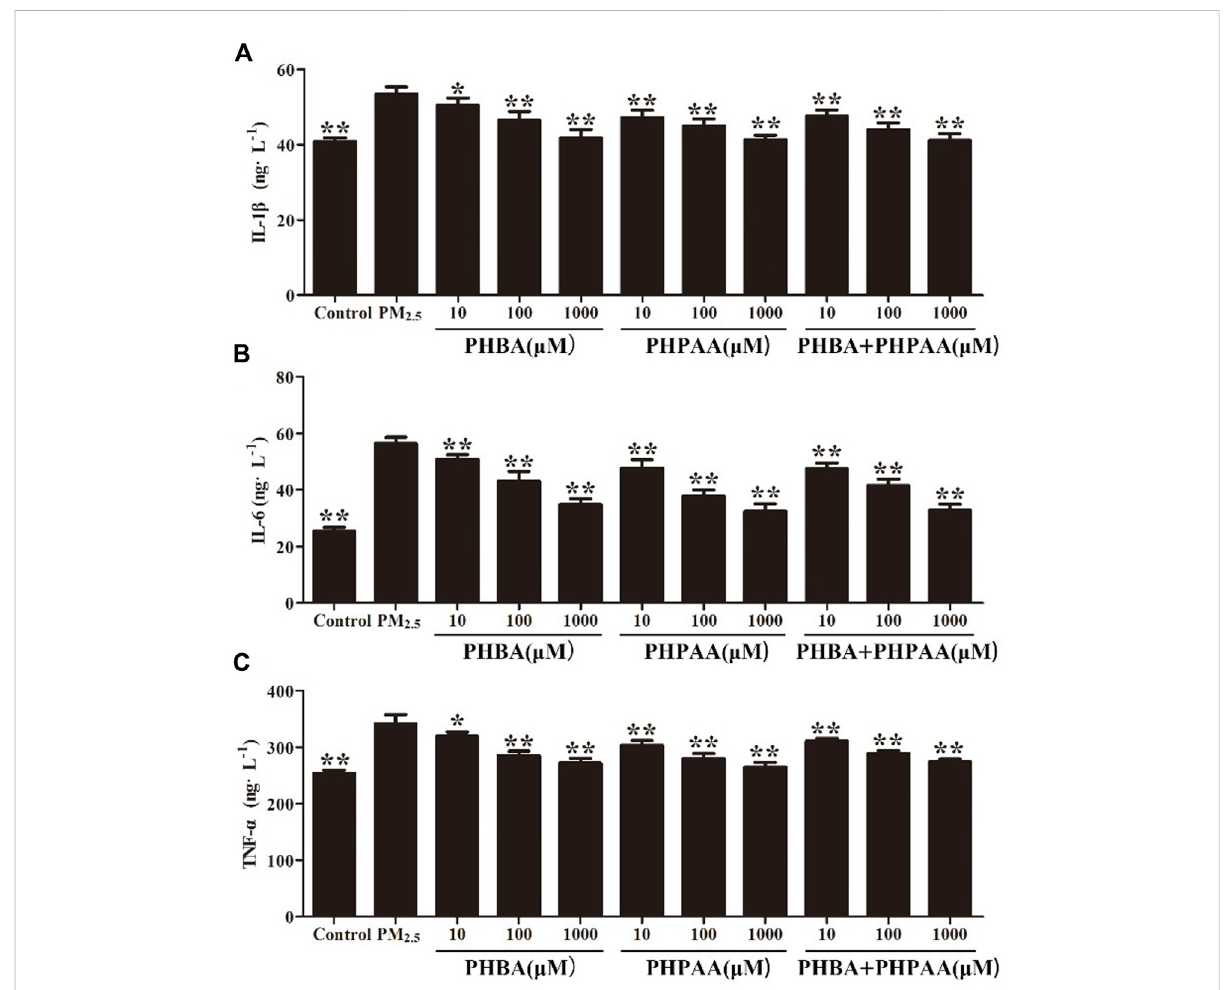
Inhibition of PHBA and PHPAA on in fl ammatory cytokines produced by PM 2.5 . (A – C) , Relative levels of IL-1 β , IL-6, and TNF- α levels at 48 h assessed by ELISA. Values are means ± SD from three separate experiments. Compared with PM 2.5 stimulation group, * p < .05, ** p <